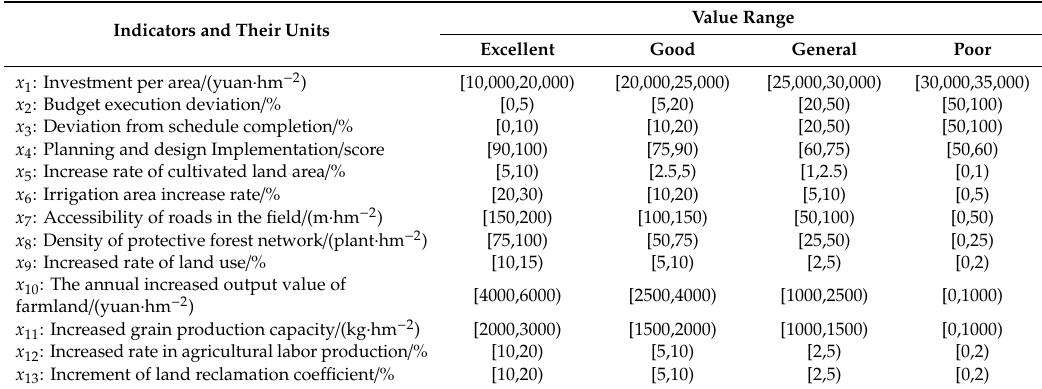
Table 2. Scale in classic domain of performance evaluation indexes of LCPs. Value Range Indicators and Their Units Excellent Good General